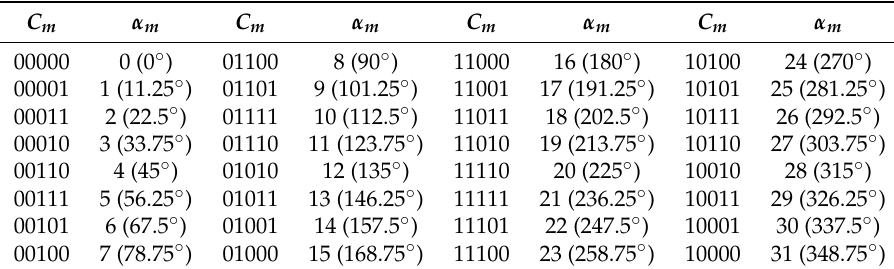
Table 2. Gray code decoder table for 5-bit